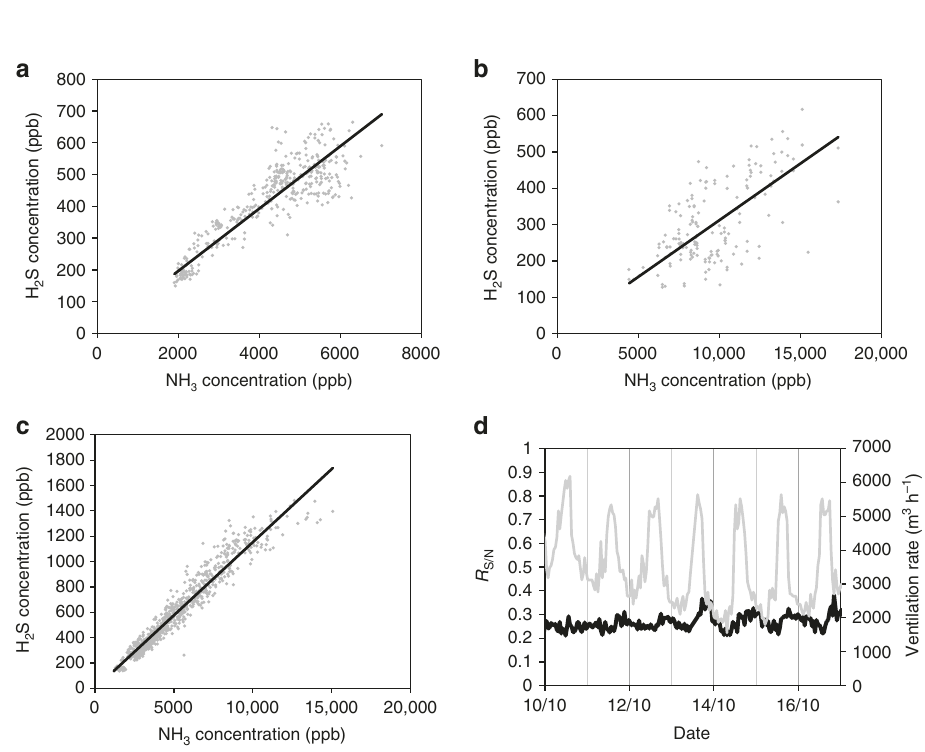
Fig. 1 Examples of correlations between measured concentrations of H 2 S and NH 3 in the ventilation outlet from two pig facilities. a Data from site 3 in 2012. b Data from site 2 in 2010. c Data from site 3 in 2011. d Temporal variation in the ratio of sulfur and nitrogen during 1 week of measurements (black line) together with temporal variation in ventilation rate with characteristic daytime maxima and nighttime minima (gray line). Full lines are least-squares linear regressions using a y axis intercept of 0. See Table 1 for